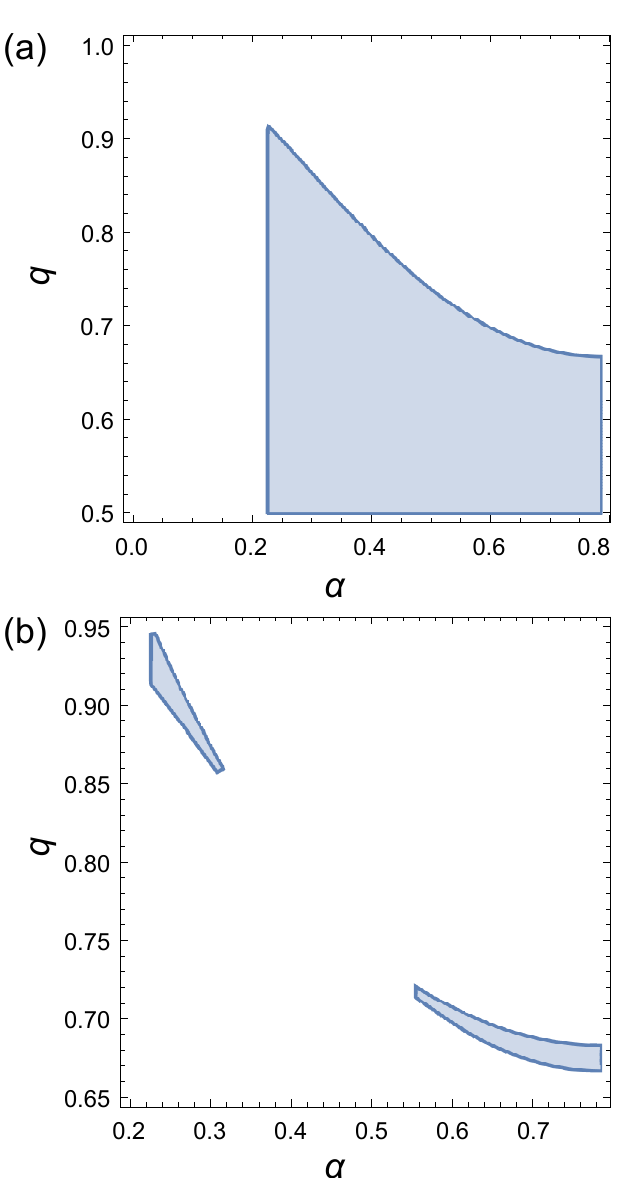
Figure 8: Shaded region in subfigure (a) gives the unsteer- able states (29) useful in the modified QKD protocol for ϵ 1 = 0 . 02119 and ϵ 2 = 0 . 02563 . Similarly, the shaded region in subfigure (b) gives steerable states that are useful in the same modified protocol (i.e., for ϵ 1 = 0 . 02119 and ϵ 2 = 0 . 02563 ). None of these states (in both subfigures) is useful in the QKD protocol (without filtering